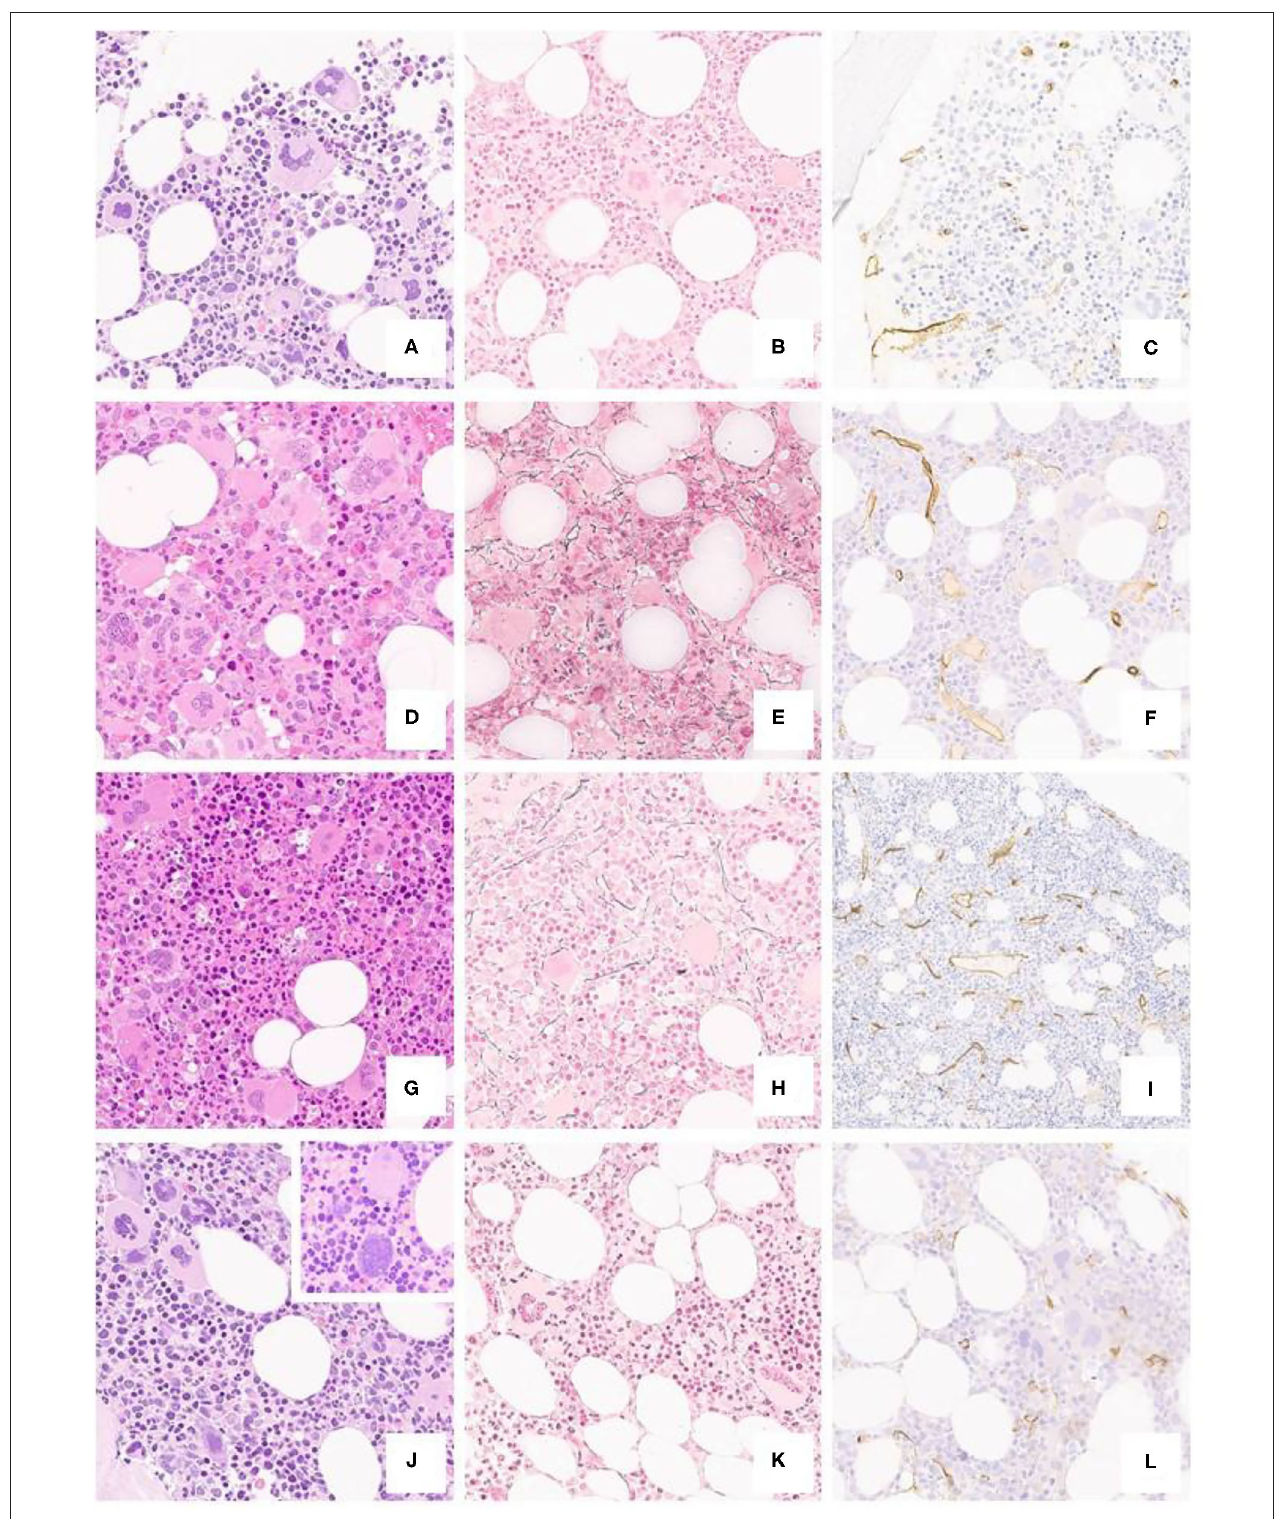
FIGURE 2 | Typical ET case from a 40-year-old patient ( a H/E, 20x), featuring a polymorphic spectrum of megakaryocytes, but with giant, hyperlobated forms and scant naked nuclei, MF-0 fibrosis ( b Gomori, 20x) and unremarkable CD34 + blasts and vessels ( c CD34, 20x). BM biopsy from a 35-year-old subject ( d H/E,